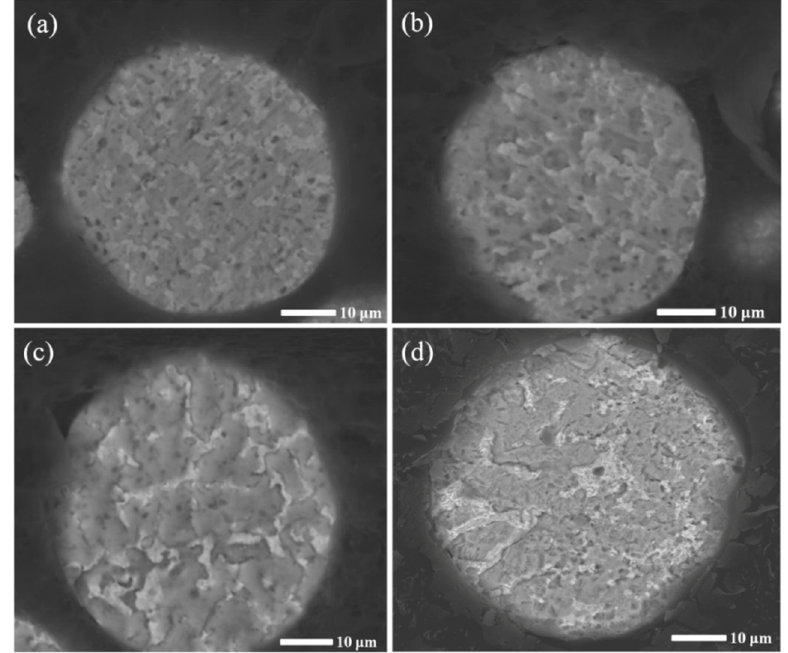
Figure 6. Cross-sectional microstructure of rapidly solidified eutectic Sn–Pb37 powder after heat treatment for 1 day in air at ( a ) 40 ◦ C, ( b ) 60 ◦ C, ( c ) 90 ◦ C, and ( d ) 120 ◦ C.